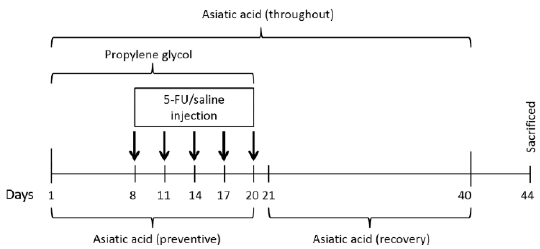
Figure 1. Timeline of animal drug administration. Single i.v. injections of 5 ‐ FU and saline are presented by thick arrows. The brackets show the period of time for propylene glycol and asiatic acid administration. 5 ‐ FU; 5 ‐ fluorouracil.